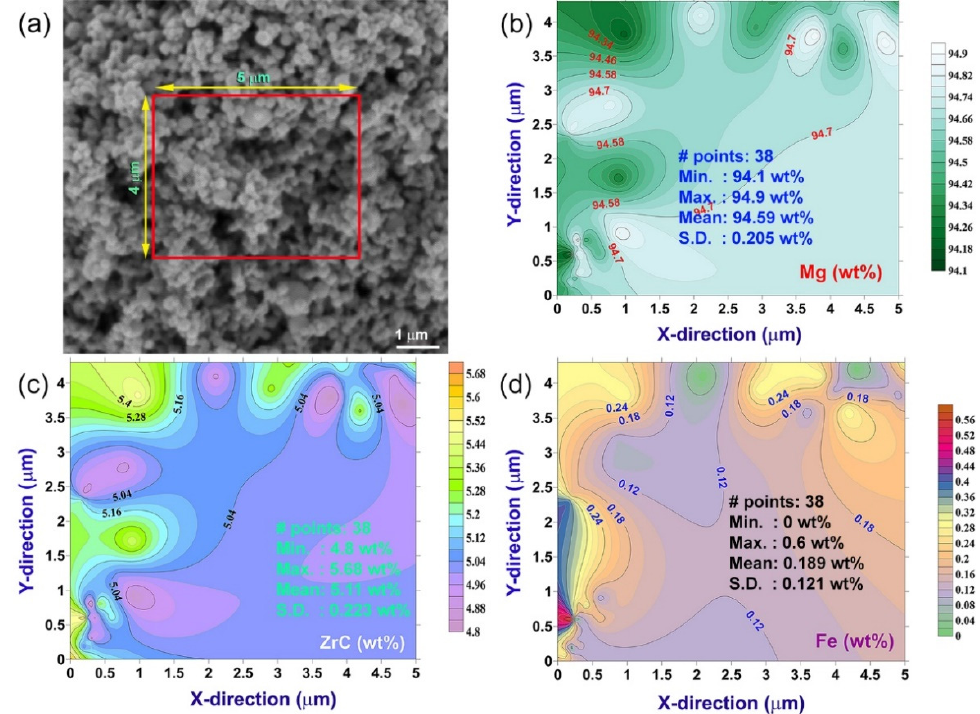
Figure 7. ( a ) FE-SEM micrograph of mechanically mixed MgH 2 /5 wt% ZrC nanocomposite powders obtained after 50 h of HEBM. The indexed rectangular zone (4 cm × 5 cm) shown in ( a ) refers